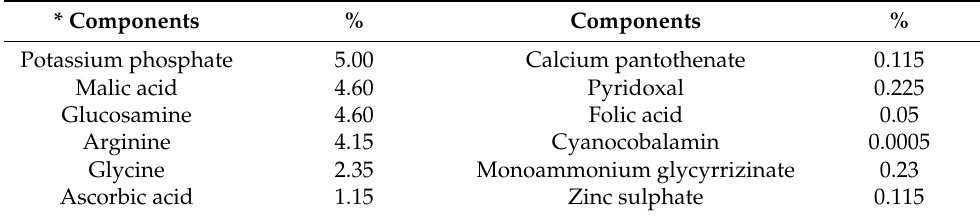
Table 4. Chemical composition of VIUSID ® agro used during 2016/2017 and 2017/2018 seasons. *